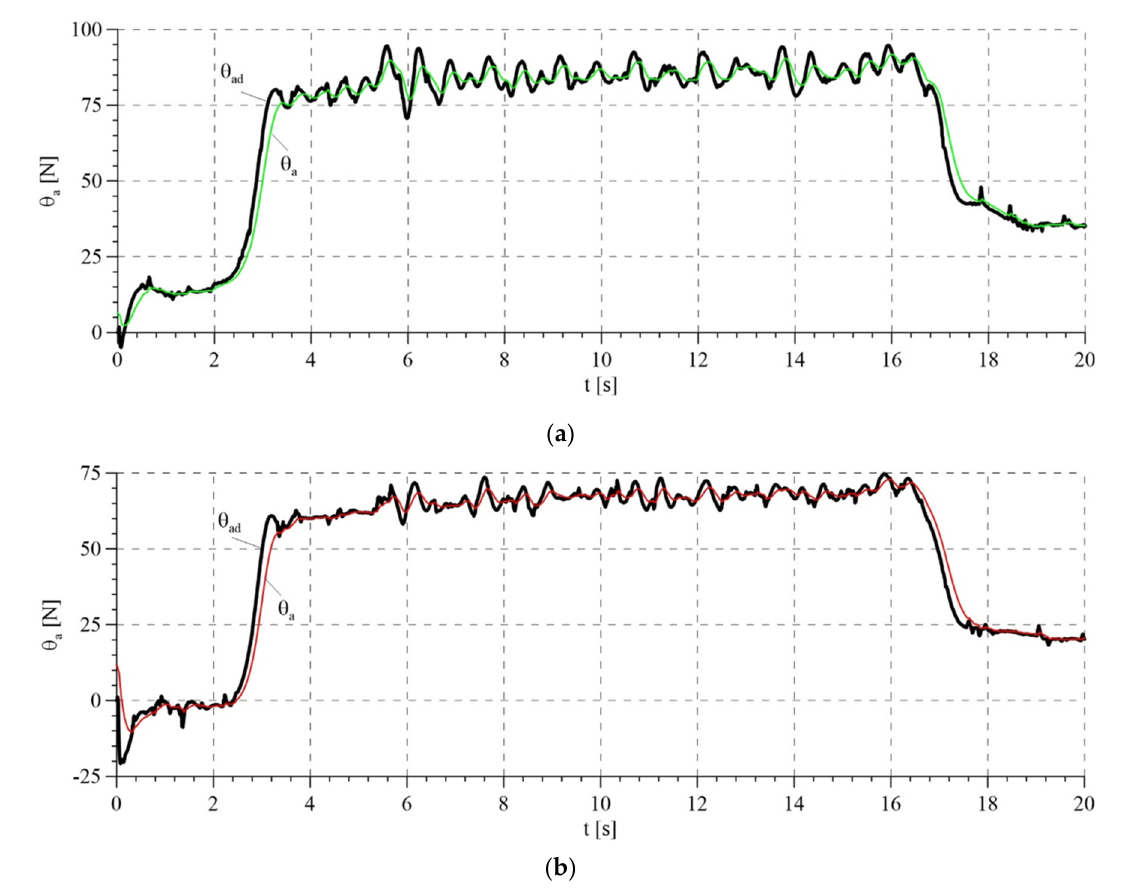
Figure 14. Overall control signals for algorithm based on the mathematical model and for the adaptive algorithm.